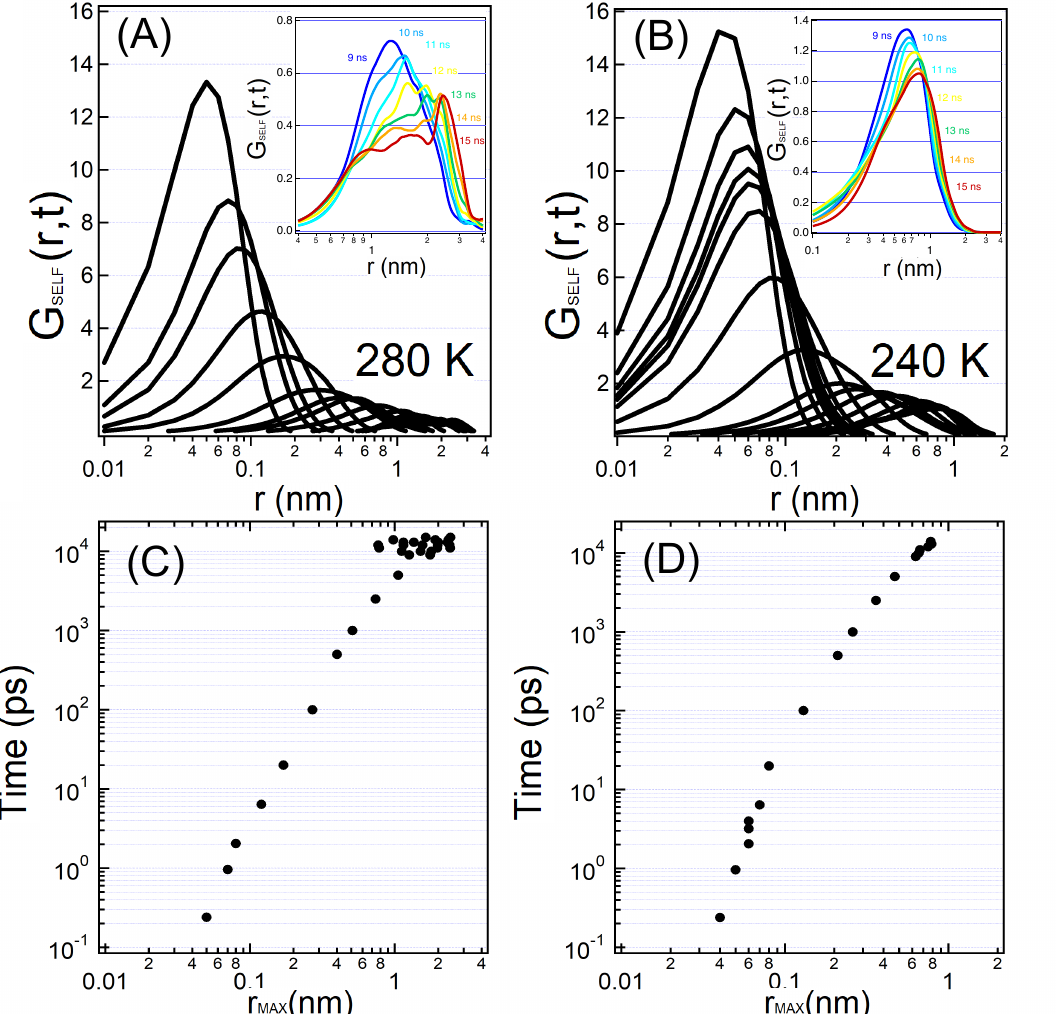
Figure 6. In order to best evidentiate the high temperature hopping phenomena, here there are plotted the hydration water oxygens SVHFs in logarithmic scale at T = 280 K (panel A ) and T = 240 K (panel B ) and the position of the peaks of the curves as a function of the time at T = 280 K (panel C ) and T = 240 K (panel D ). At T = 280 K we clearly observe the presence of multiple peaks concentrated between 9 and 15 ns. This long relaxation due to the protein motion is much slower than the α relaxation at the corresponding temperature. At T = 240 K we mainly observe the evolution of the α peak which moves over longer distance over time. For temperatures lower than T = 250 K (at the PDT and below) we have more difficulties to observe the hopping that determines the strong behaviour of the long relaxation because the long relaxation shifts to times that are long compared to the timescale of our